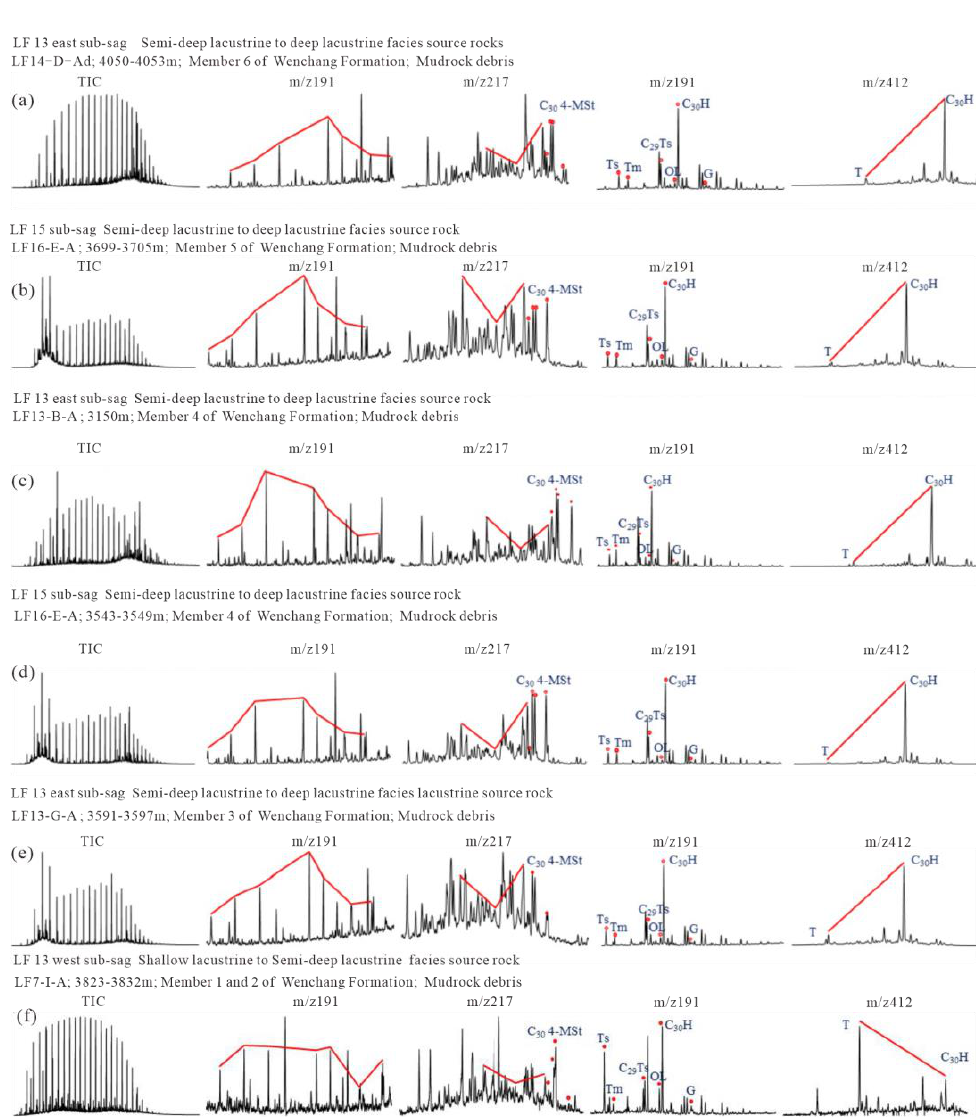
Figure 4. Characteristics of the biomarker in the typical source rocks of the WC in the southern Lufeng sag; ( a ) hydrocarbon source rocks of the WC6; ( b ) hydrocarbon source rocks of the WC5; ( c ) hydrocarbon source rocks of the WC4; ( d ) hydrocarbon source rocks of the WC3; ( e ) hydrocarbon source rocks of the WC2; ( f ) hydrocarbon source rocks of the WC1 and WC2.4.2; Crude Oil Source.